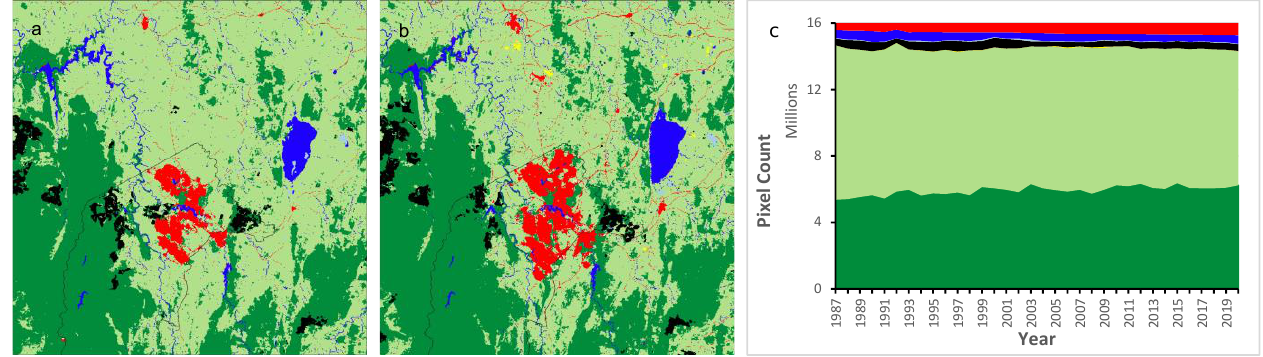
Figure 4. U-Net CNN model results for 1987 ( a ); and 2020 ( b ); and land cover class distribution ( c ) (legend as for Figure 3). Table 5. Extent of predicted land cover classes for 1987 and 2020 showing changes.